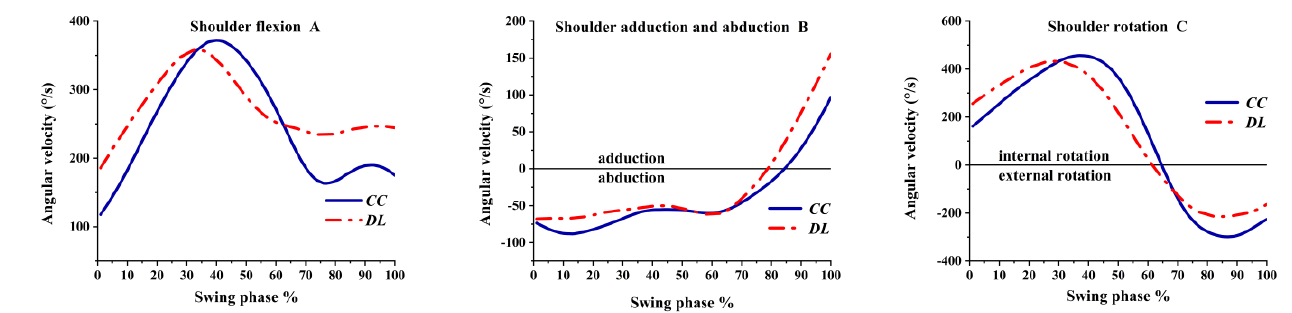
Figure 9. The angular velocity of the shoulder during the swing phase.